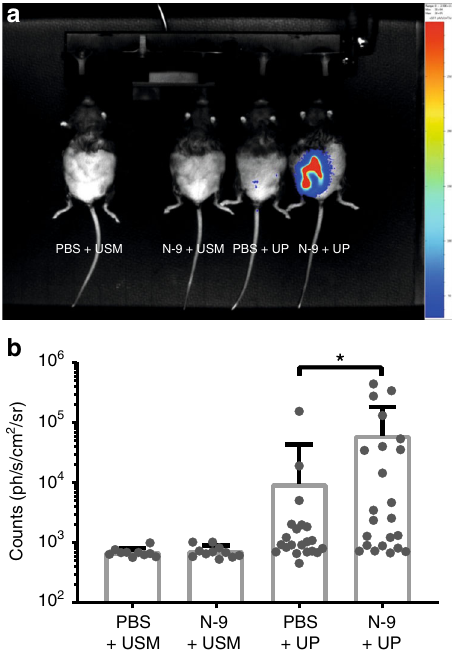
Fig. 4 Increased BLI signal by vaginal UP in the presence of cervical damage. In the afternoon of D16 of gestation, mice received either 10% N-9 in PBS or PBS control via intravaginal inoculation. After 16 h, in the morning of D17 of gestation, mice received either luciferease-expressing UP in ureaplasma-selective medium (USM) or USM control via intravaginal inoculation. After 24 h, in the morning of D18, the luciferase substrate Furimazine was injected intraperitoneally to allow UP localisation. A representative image is shown a . Bioluminescence signal was quanti fi ed in a region of interest (ROI) covering each mouse ’ s abdomen. Bioluminescence signal coming from luciferase-expressing UP was signi fi cantly increased in mice that have been pre-treated with N-9 ( n = 23) compared to PBS controls ( n = 22) ( b ). Error bars indicate SD. Statistical signi fi cance was assessed using unpaired t test on log-transformed values of bioluminescence quanti fi cation for PBS + UP vs. N-9 + UP (* P = 0.0131) ( n = 10 for PBS + USM, n = 11 for N-9 + USM). Source data are provided